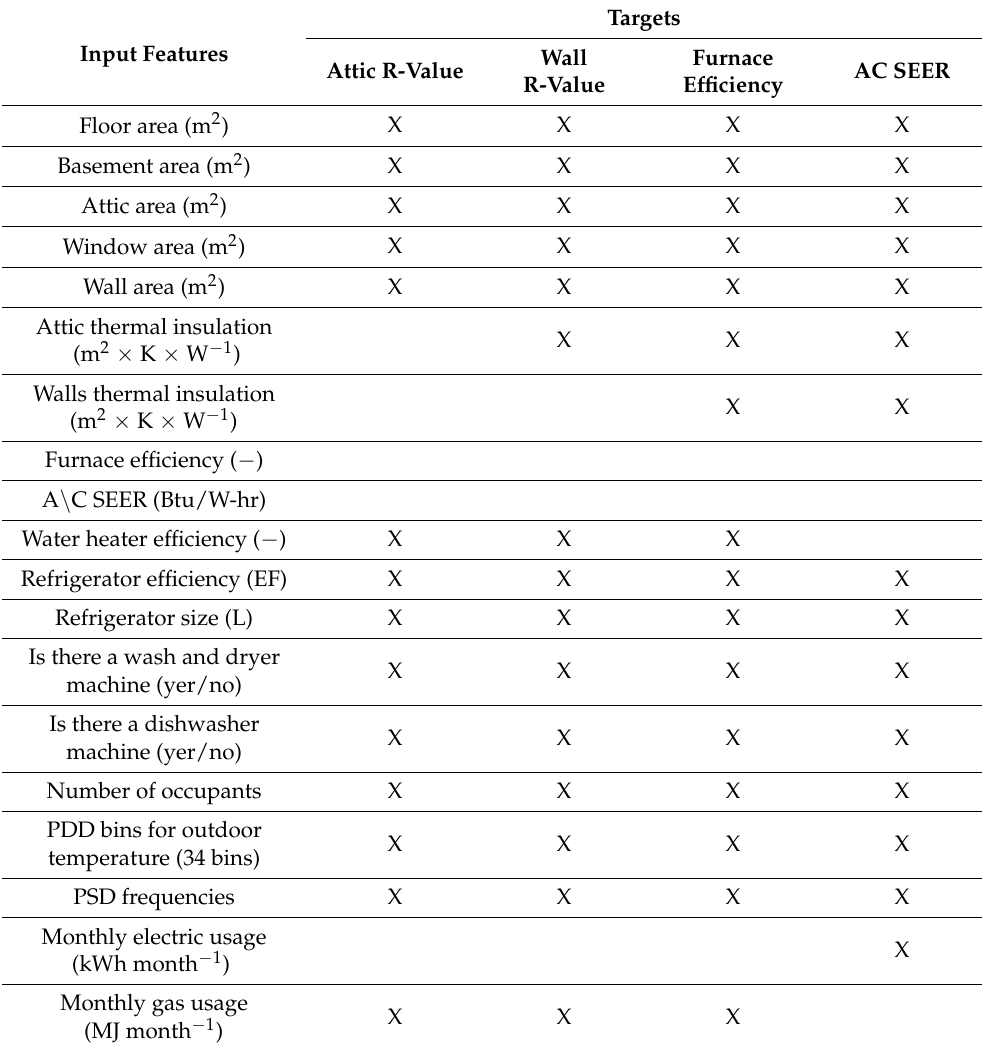
Table 3. Input features used to develop each target model (X means selected